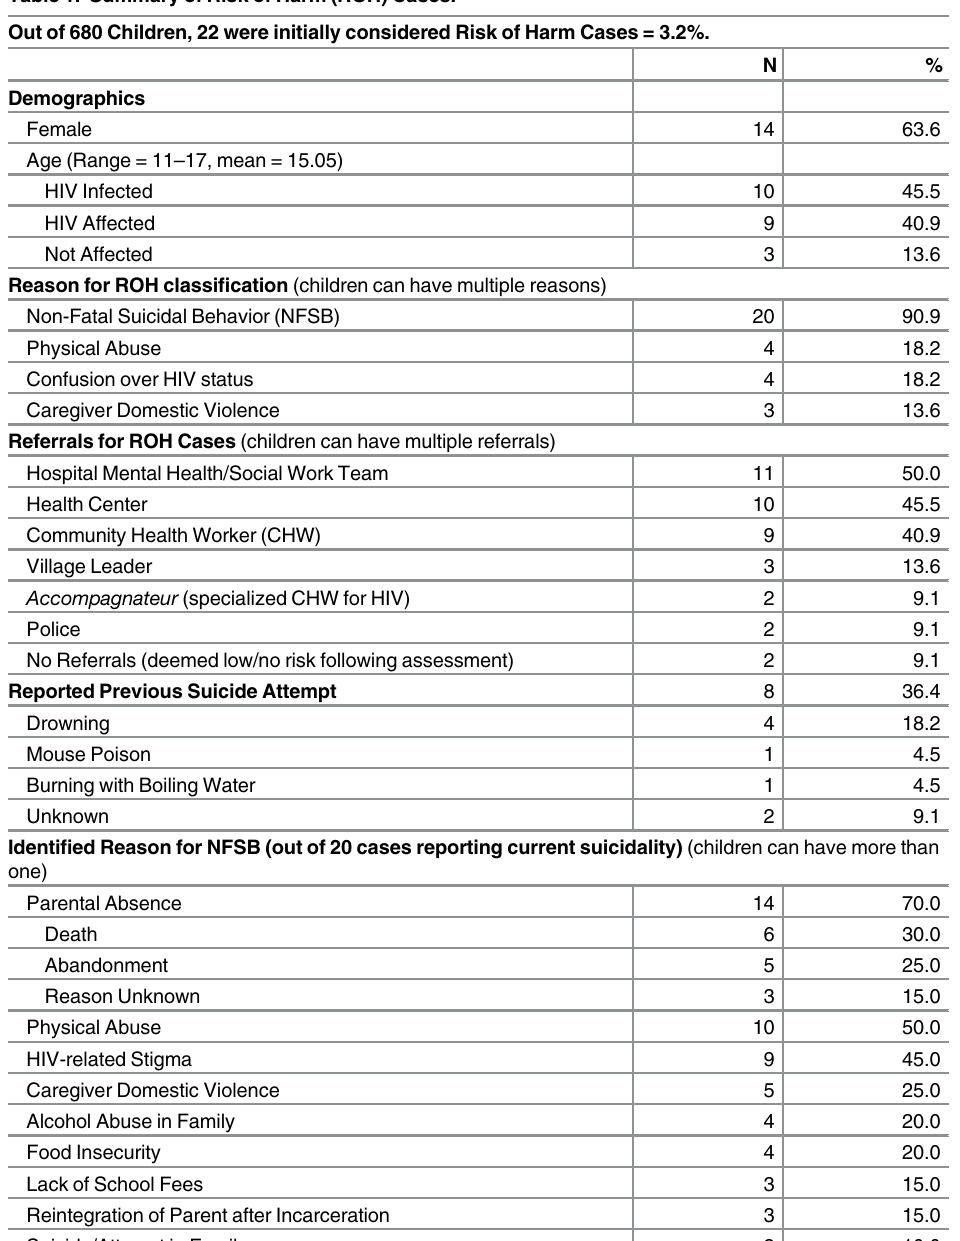
Table 1. Summary of Risk of Harm (ROH)